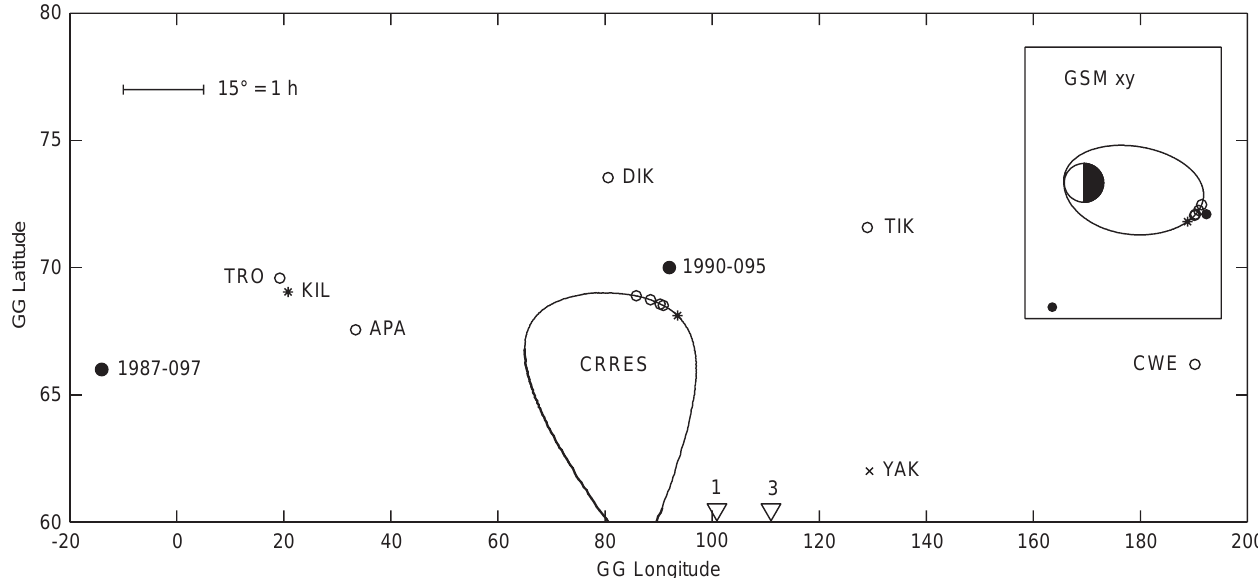
Fig. 1. Satellite footprints and ground stations in geographic coordinates on February 9, 1991. The substorm onset (*) and the four intensifications (o) are marked along the CRRES orbit (see text